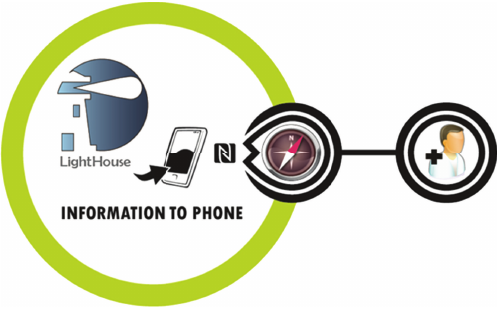
Figure 13: Maps and contact information by